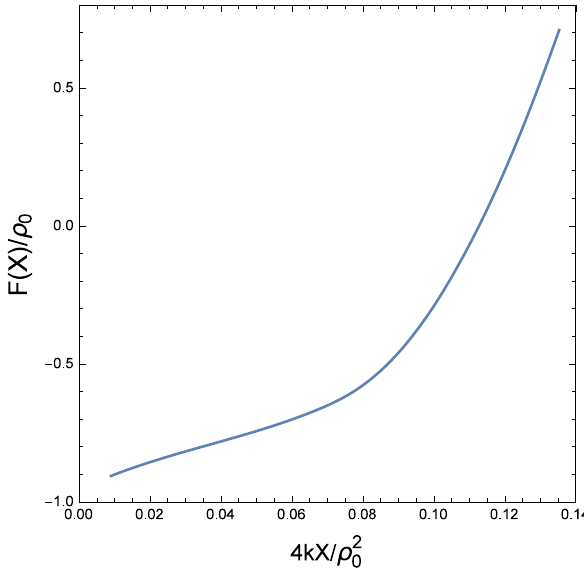
Fig. 4 Here the reconstructed F ( X ) is shown based on the from the SNIa data